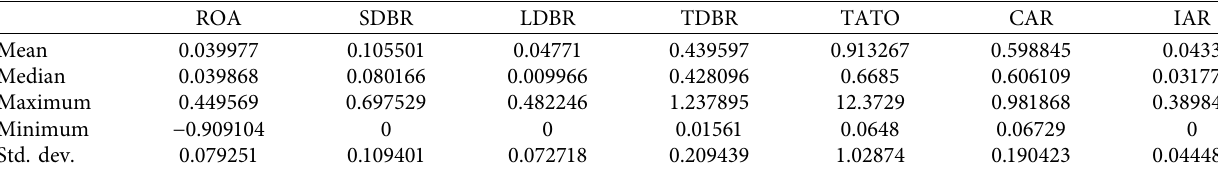
Table 2: Descriptive statistics of variables.